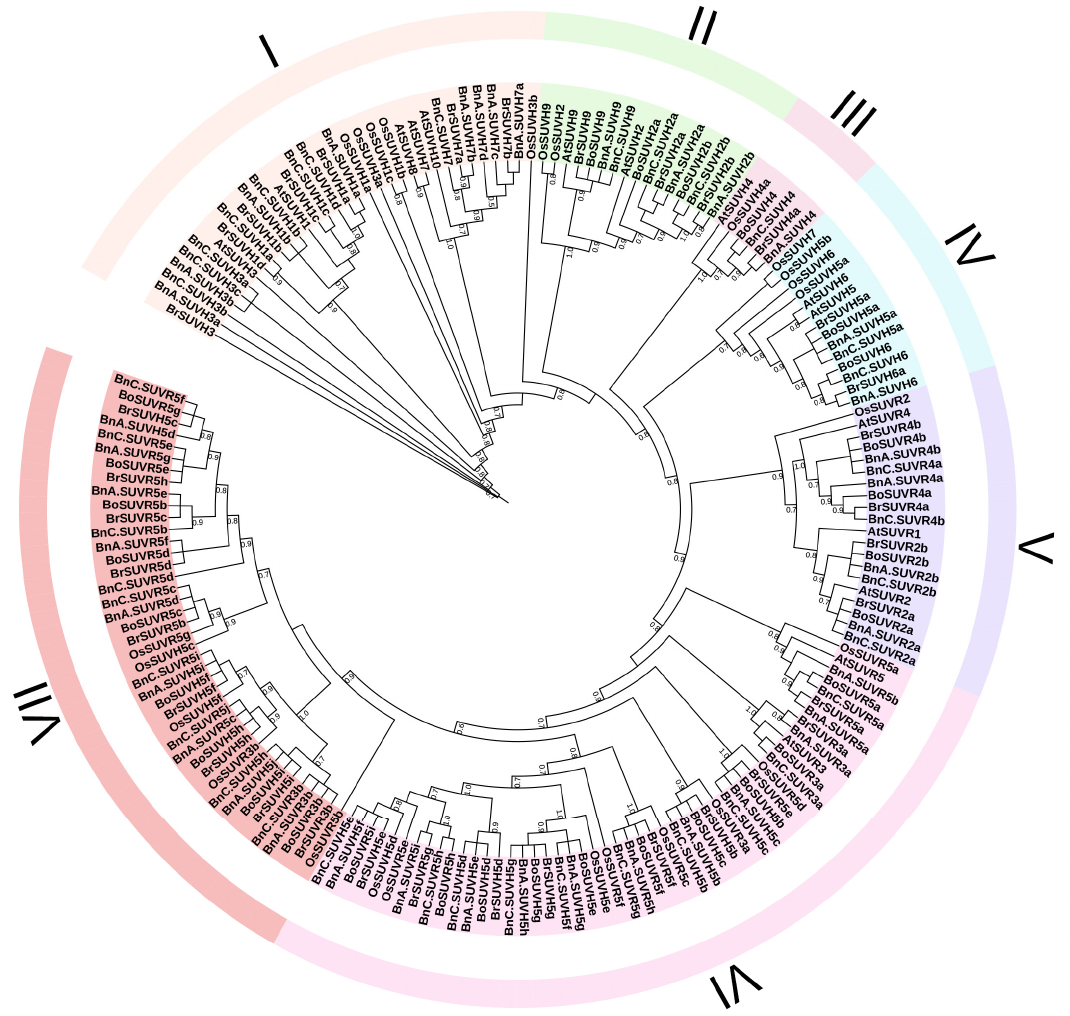
Figure 1. Phylogenetic tree of SUV gene family in B. rapa , B. oleracea and B. napus , Arabidopsis and rice, including 180 SUV proteins, was divided into I-VII seven groups. The bootstrap value which was greater than 50% was displayed at the base of the branch.